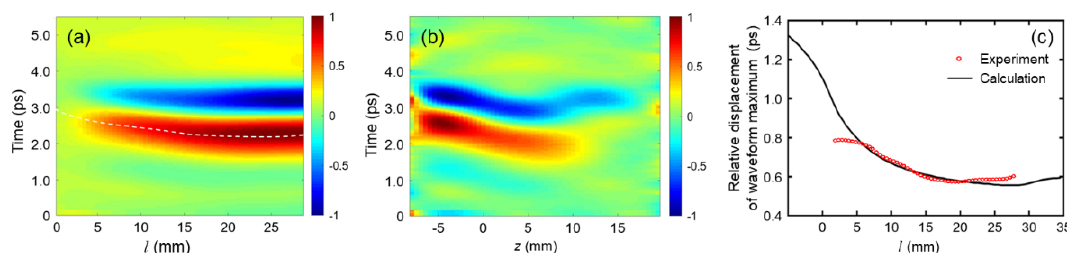
Figure 5: Comparison between the experimental and theoretical results of THz wave temporal shift. (a) The recorded THz waveforms emitted from different fil- ament lengths l . (b) THz pulses generated at each z position, achieved by applying differential on the data in (a). (c) The relative displacement of the temporal wave- form maximum obtained from Fig. 4(c ) as the black line, and from Fig. 5(a) as 3 the red circles. Note that, the latter was offset along the ps-axis for fitting with the